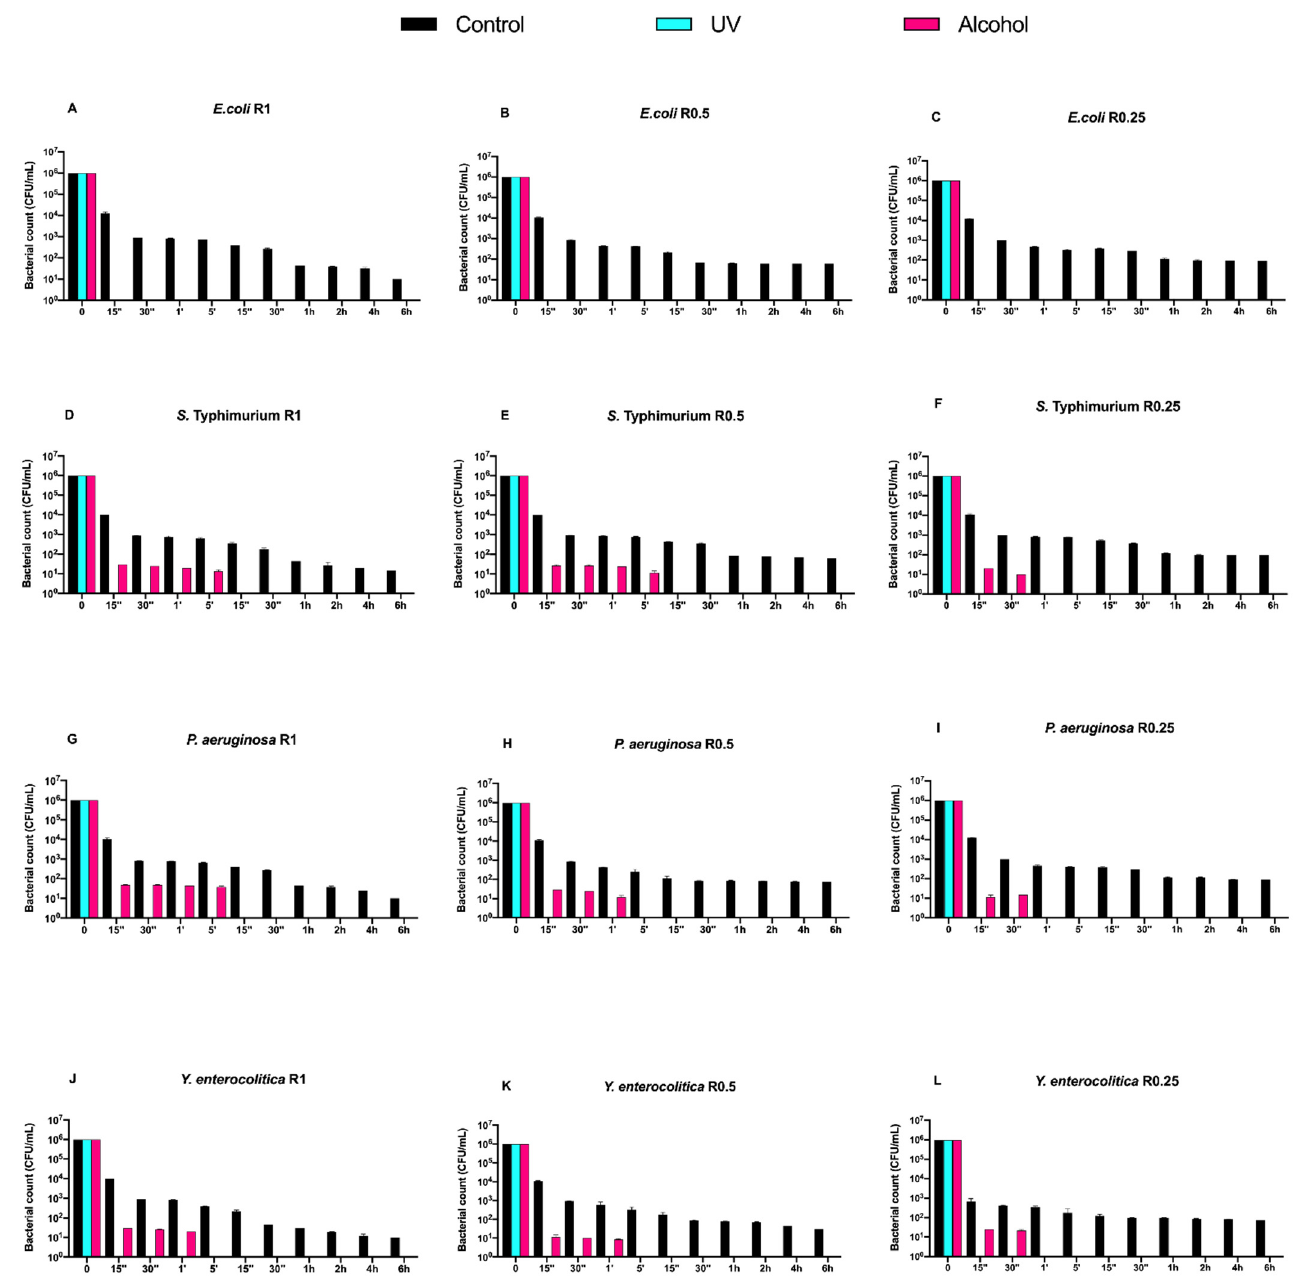
Figure 5. Graphical representation of Gram-negative bacterial counts (A-L) at different exposure times on DURALTI ® -coated aluminum disks with different surface roughness (R0.25, R0.5 and R1 µ m) and subjected to UV and alcohol sanitizing methods.